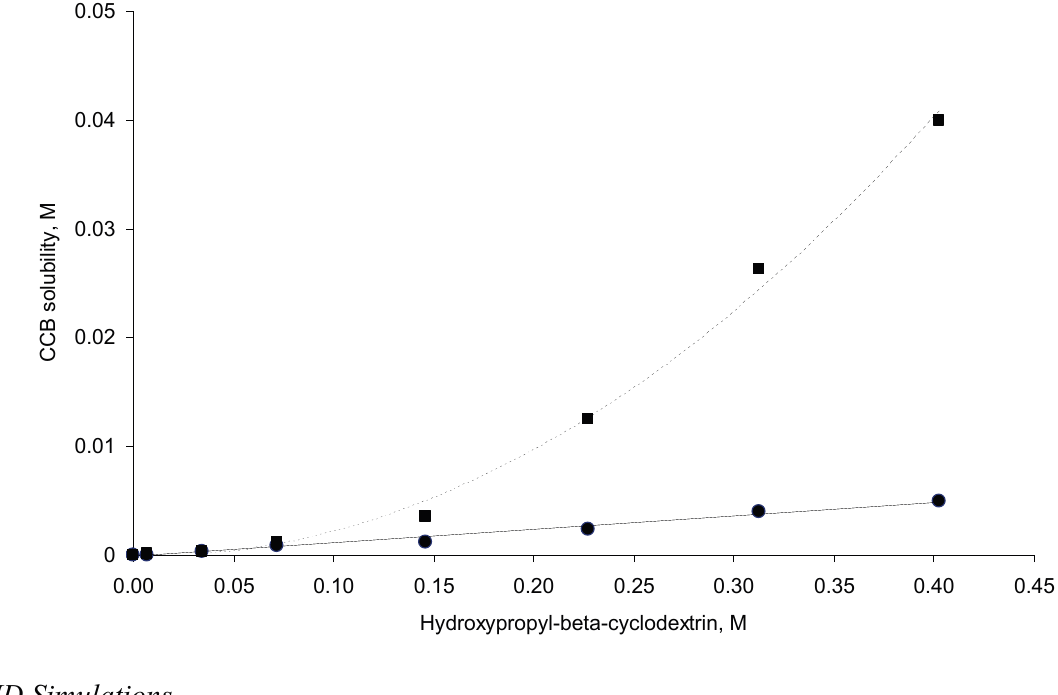
Figure 2. Solubility phase profiles of the celecoxib (CCB)–hydroxypropyl- β -cyclodextrin (HP- β -CD) system at 298 °K (solid circles) and 333 °K (squares).